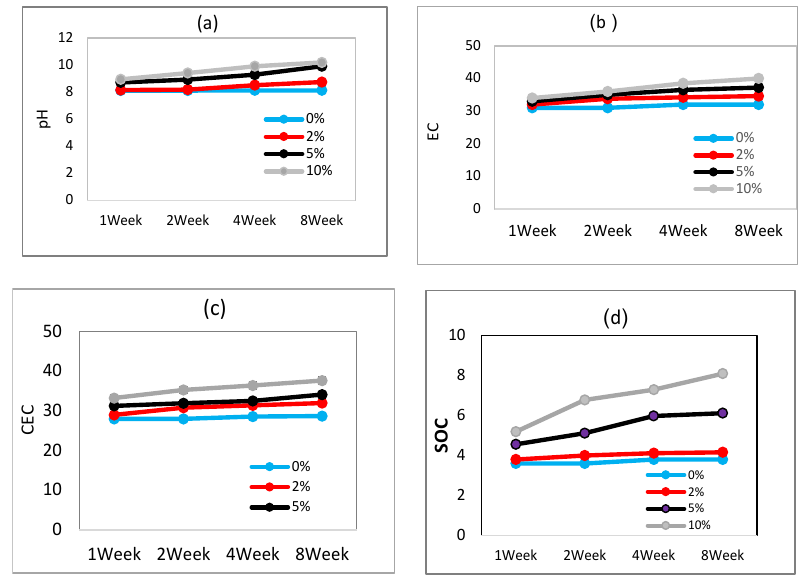
Figure. 3. Amendment effect on soil properties: pH(a), Electrical Conductivity (EC) (b), Cation Exchange Capacity (CEC) (c), Soil Organic Carbon (SOC)